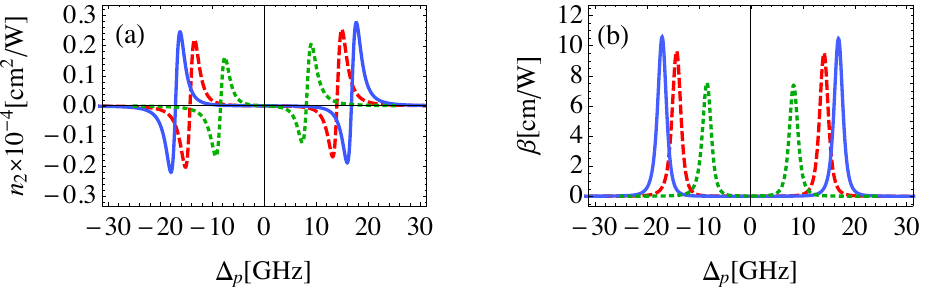
Figure 5. The self-Kerr nonlinear index of refraction ( a ) and nonlinear absorption coefficient ( b ) in the MNP-GND-QD hybrid system of R QG = 13 nm, θ G = 1 rad, R GM = 26 nm, θ M = 0.55 rad (solid), R GM = 28 nm, θ M = 0.5 rad (dashed) and R GM = 34 nm, θ M = 0.4 rad (dotted). The system is excited with resonant control field of Ω c = 50 GHz.